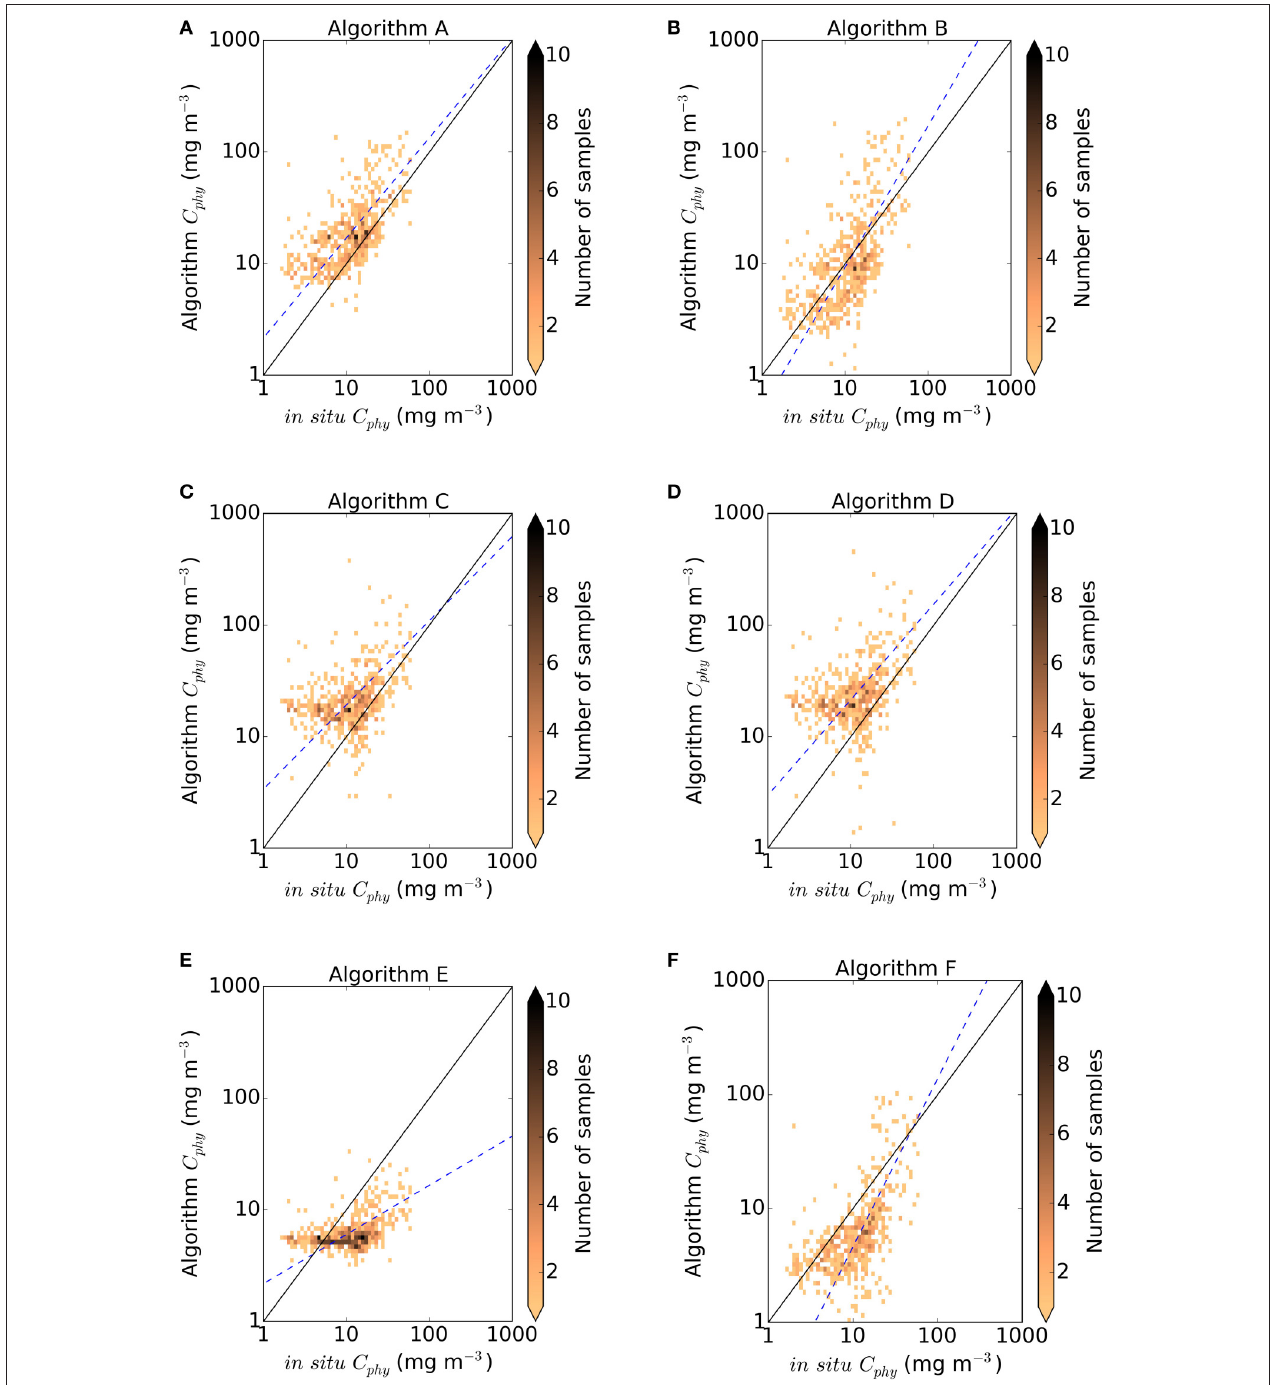
FIGURE 3 | Density plot of in situ vs. algorithm C phy from the match-up database ( N = 557). Black solid line is the 1:1 line and blue dashed line is the Type II linear regression (Reduced Major Axis) fitted to the log 10 converted data. (A) Sathyendranath et al. (2009), (B) Marañón et al. (2014), (C) Behrenfeld et al. (2005), (D) Martínez-Vicente et al. (2013) modified, (E) Kostadinov et al. (2009, 2016), (F) Roy et al. (2017).